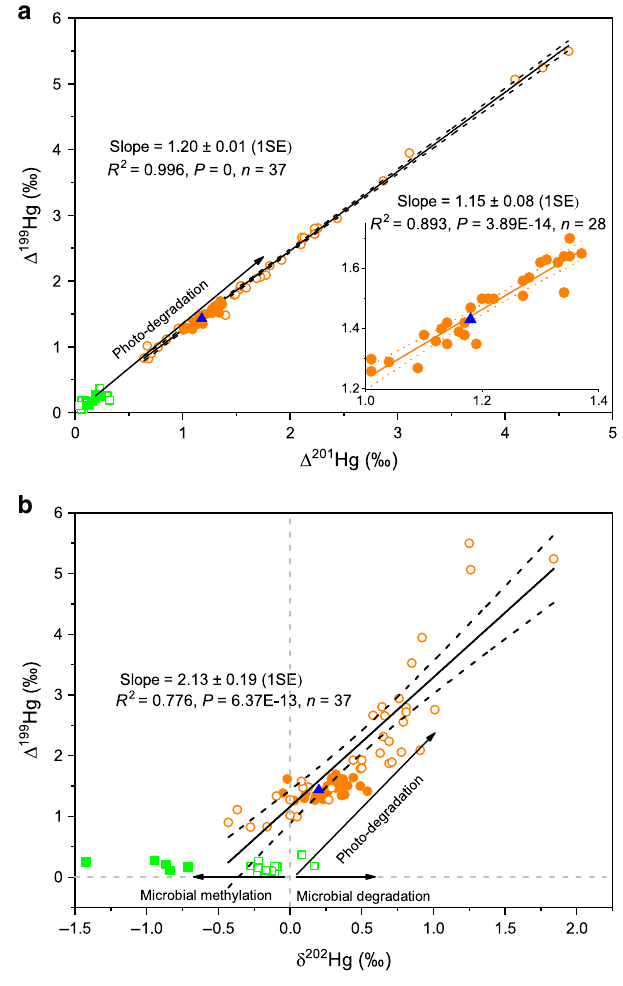
Fig. 4 Correlations of mercury isotope values in trench samples. a Δ 201 Hg versus Δ 199 Hg, and b δ 202 Hg versus Δ 199 Hg. Also shown are the marine particles and fi shes from North Paci fi c Subtropical Gyre 16,32 , and the linear regression lines of Hg isotope compositions for fi shes 16,32 . The inset in a shows the linear regression line of Δ 201 Hg versus Δ 199 Hg in trench fauna. Symbols for samples are the same as in Fig. 2. SE is the standard error, and n is the number of samples. The arrows show the experimental isotope fractionation trajectories during microbial methylation of IHg(II) 51 – 53 , and microbial and photodegradation of MMHg 39,42 . The typical 2 SD ana- lytic uncertainty of our fauna (sediment) samples was 0.08 ‰ (0.08 ‰ , two standard deviation) for δ 202 Hg, and 0.10 ‰ (0.04 ‰ , two standard deviation) for Δ 199 Hg and Δ 201